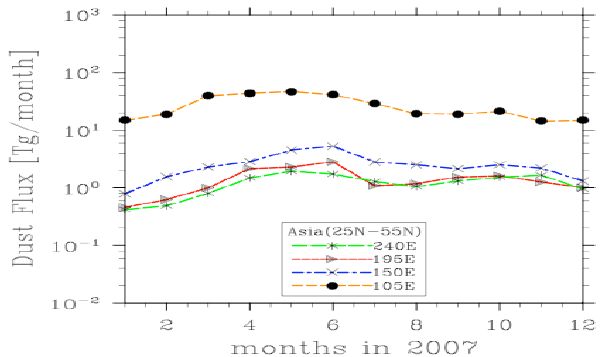
Fig. 6. Modeled monthly dust fluxes (25 ◦ N–55 ◦ N) across different longitude planes (105 ◦ E, 150 ◦ E, 195 ◦ E, and 240 ◦ E) for Asian dust in